Question: What form of chart is displayed?
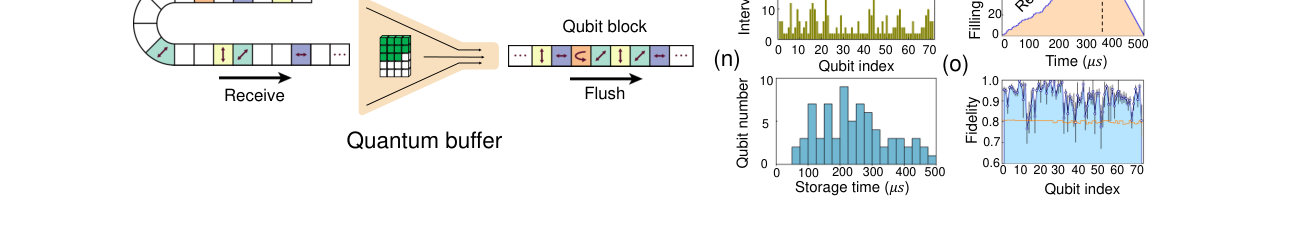
Answer: bar